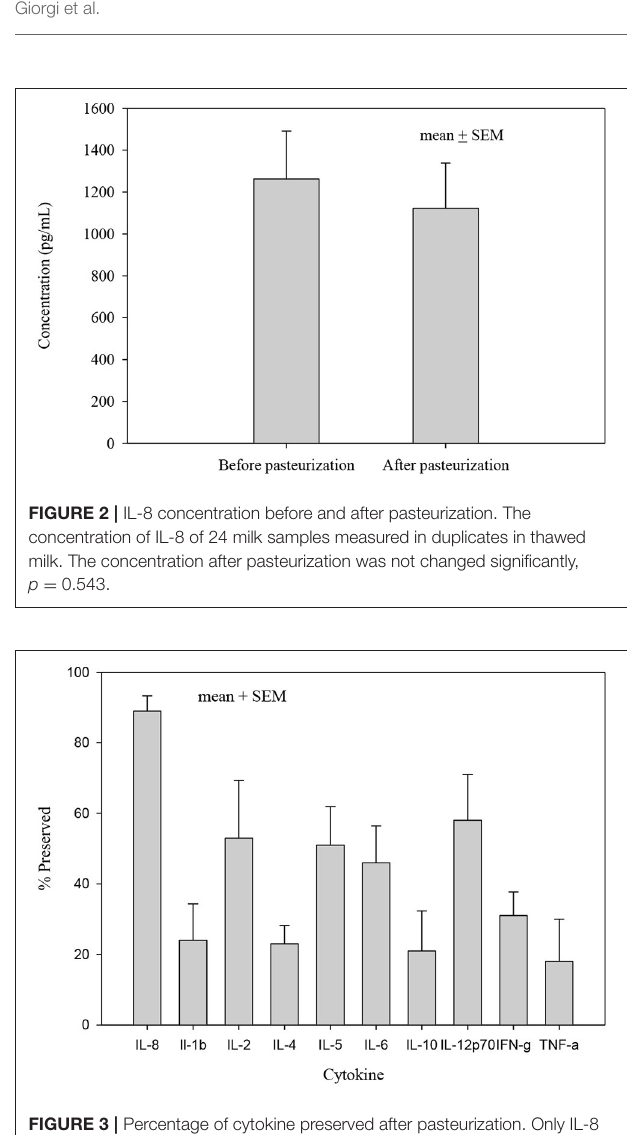
FIGURE 3 | Percentage of cytokine preserved after pasteurization. Only IL-8 concentration in heat treated human milk was preserved (89%) compared with other cytokines which were significantly less preserved after heat treatment, p <